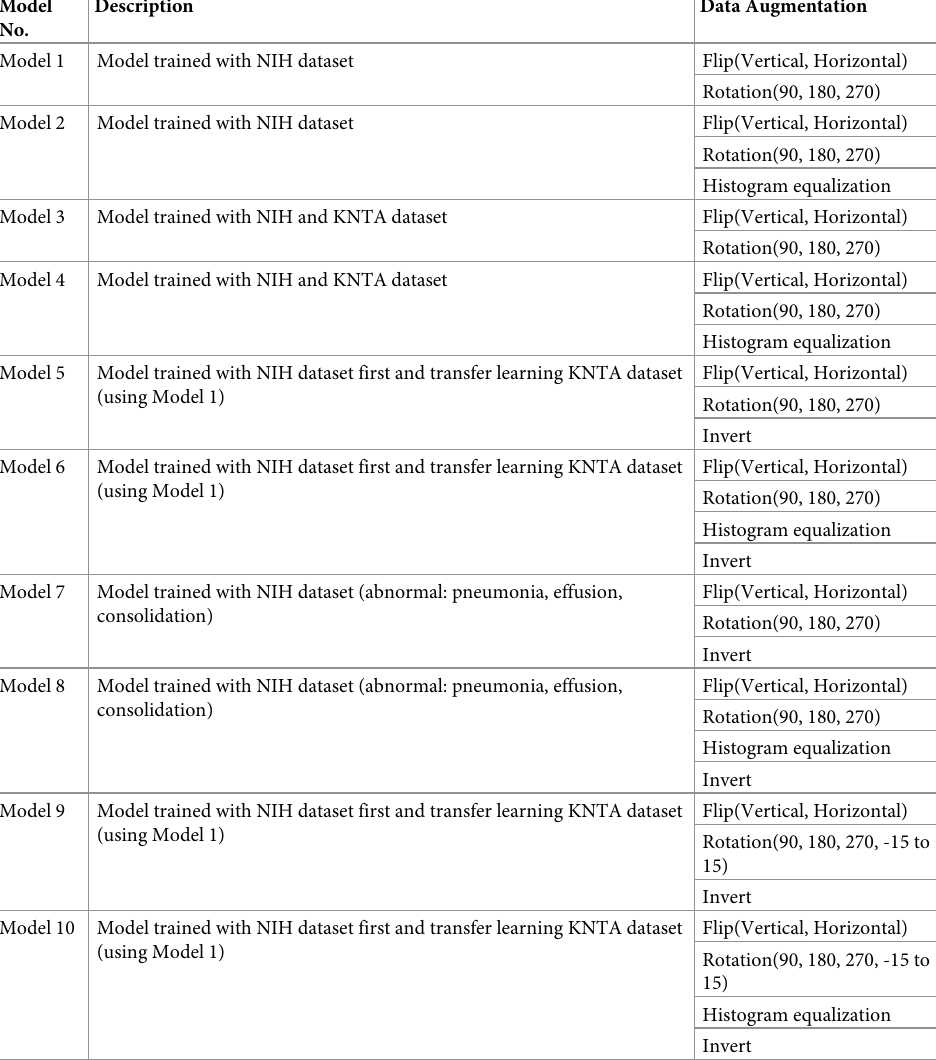
Table 2. Summary of AI models for the diagnosis of